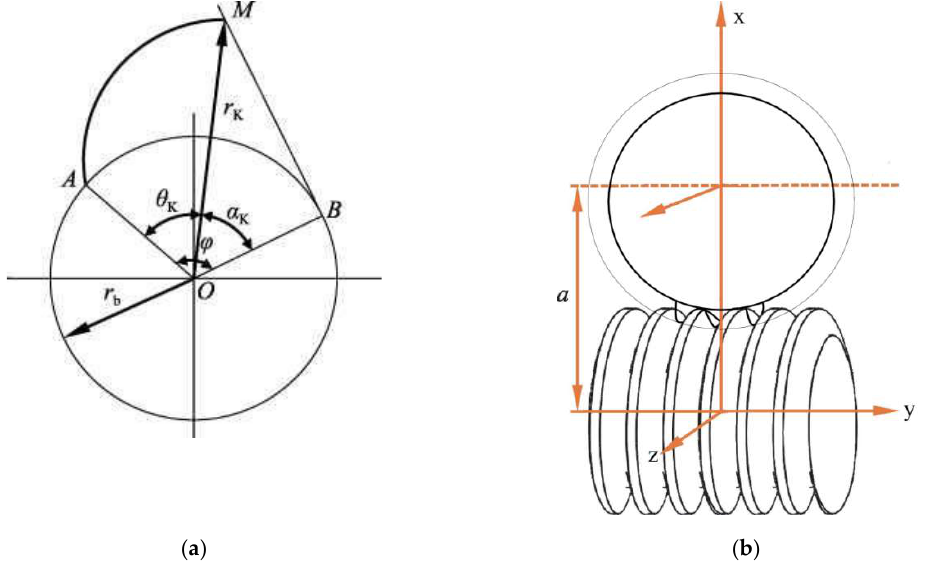
Figure 3. ( a ) Involute forming principle; ( b ) Grinding diagram of worm grinding.